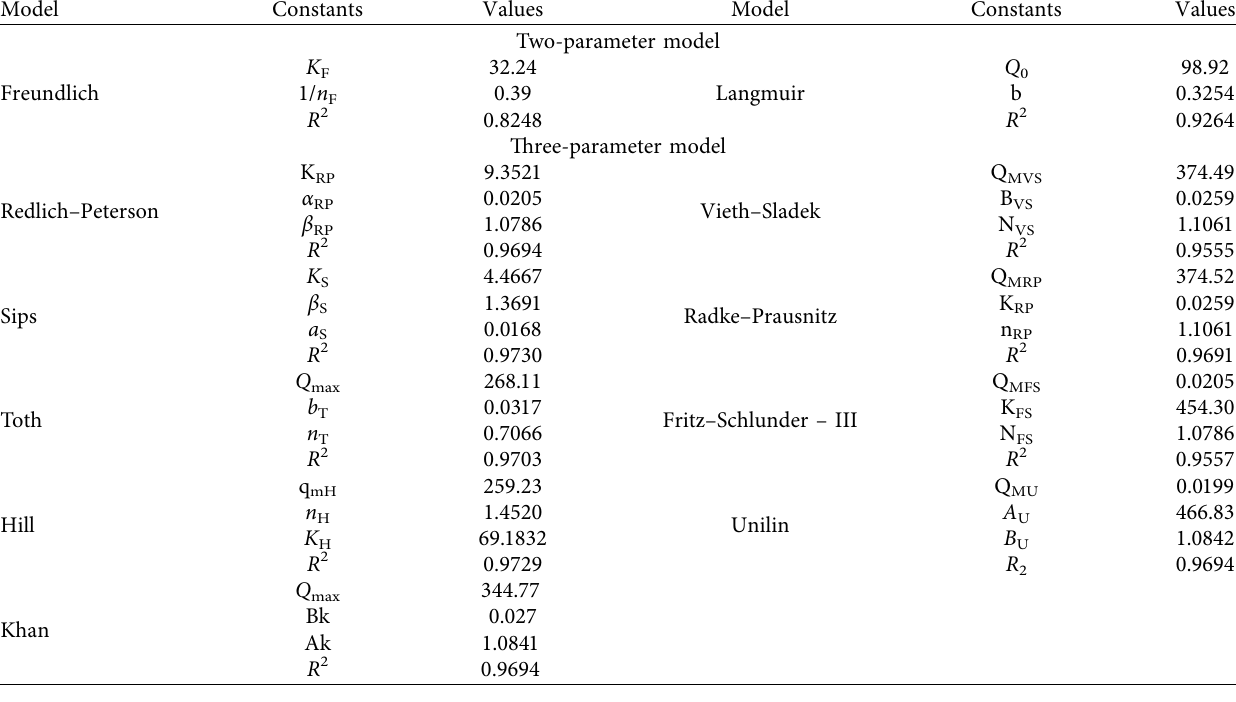
Table 3: Adsorption isotherm model constants.